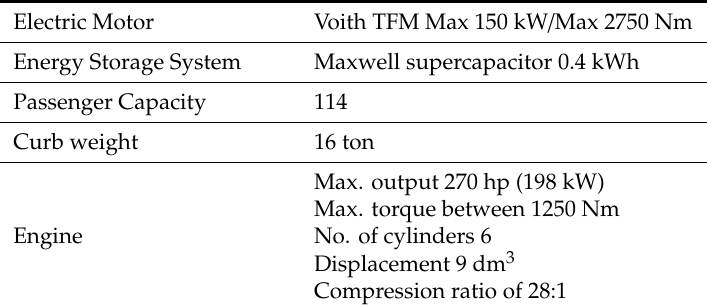
Figure 3. HEV-ED95 hybrid powertrain. Table 3. Technical specifications of Scania Omnilink HEV-ED95